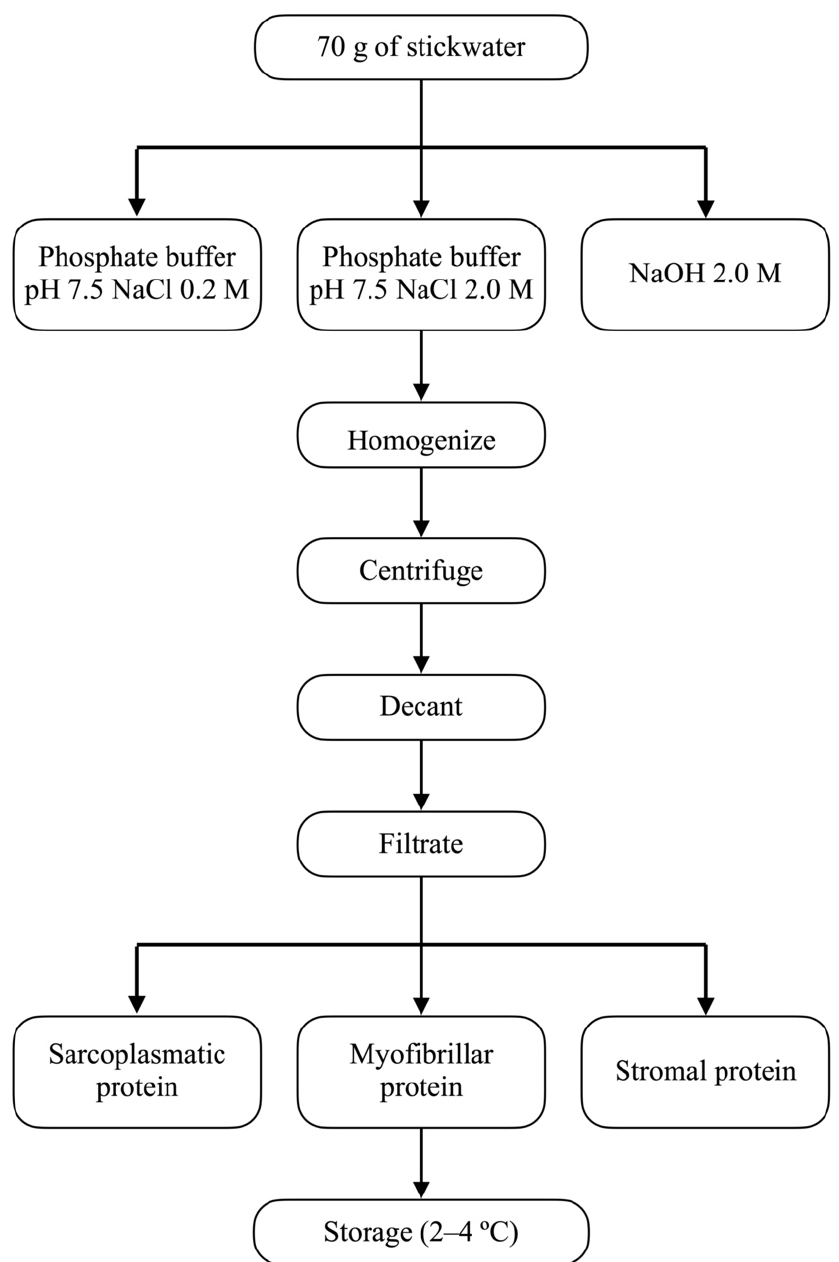
Figure 1. General diagram of the stickwater protein-separation